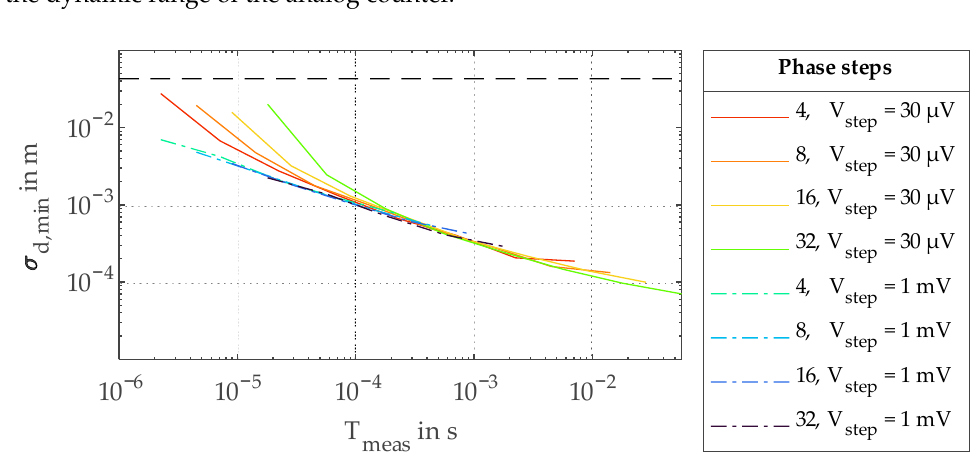
Figure 6. Standard deviation σ d over P opt for different T int .: ( a ) with 32 phase steps, V step = 30 µV; ( b ) with 16 phase steps, V step = 30 µV; ( c ) with 8 phase steps, V step = 30 µV; ( d ) with 4 phase steps, V step = 30 µV; ( e ) with 32 phase steps, V step = 1 mV.